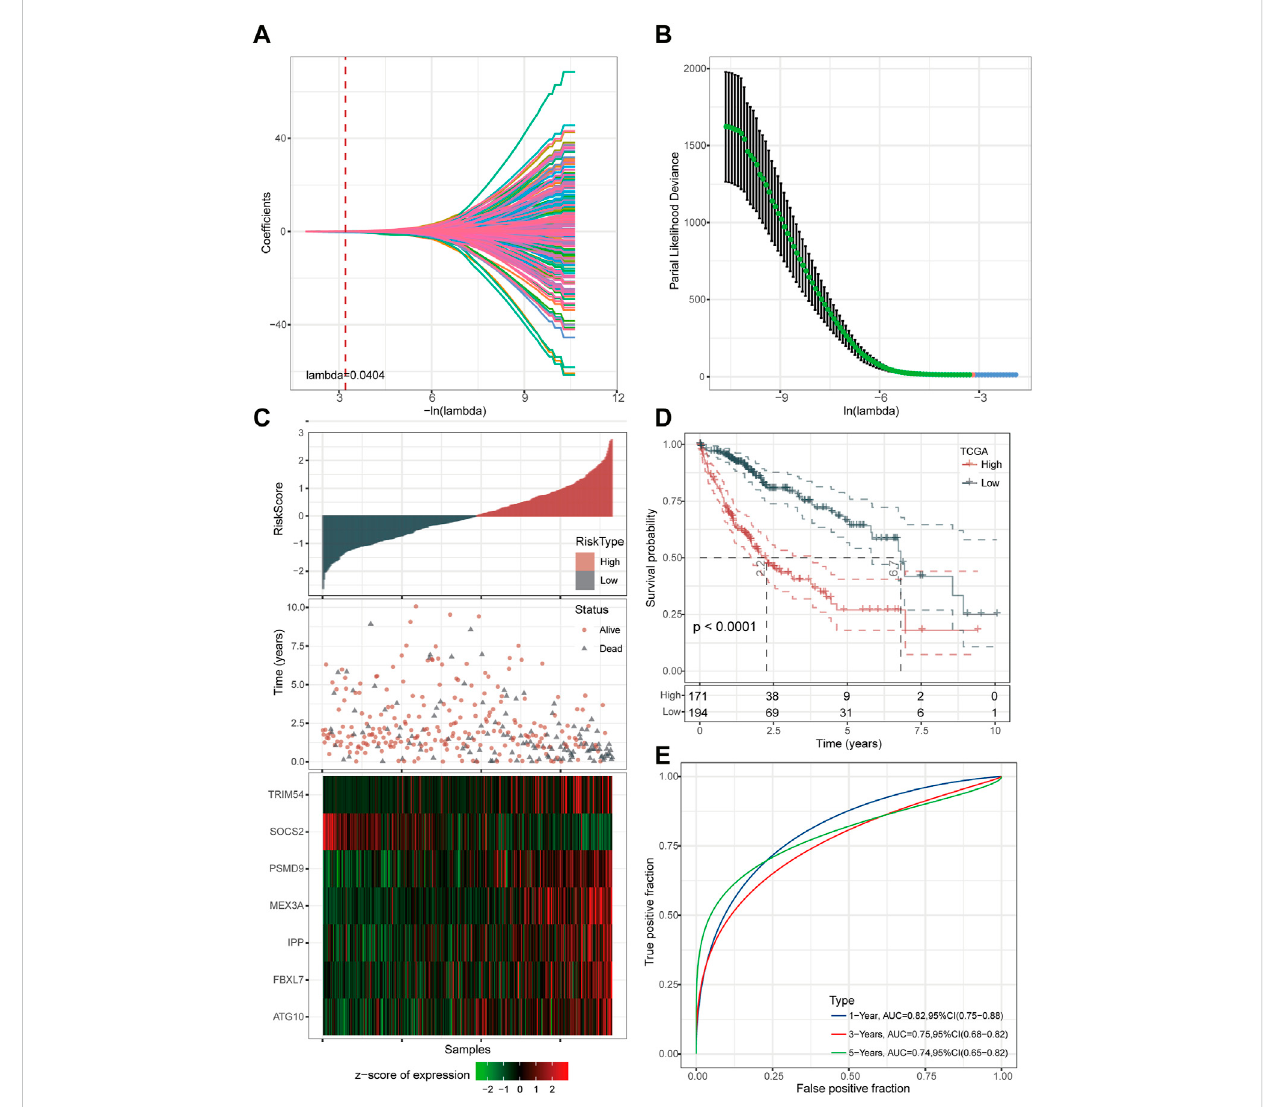
FIGURE 3 Determination of key genes for risk model construction. (A) Independent variable coef fi cients. (B) 10-fold cross-validation determining the con fi dence interval under each lambda.2 (C) Distribution of seven UPS-based signatures. (D) Kaplan-Meier curves of high- and low-risk patients in the TCGA cohort. (E) ROC curves with AUCs for 1-year, 3-year, and 5-year